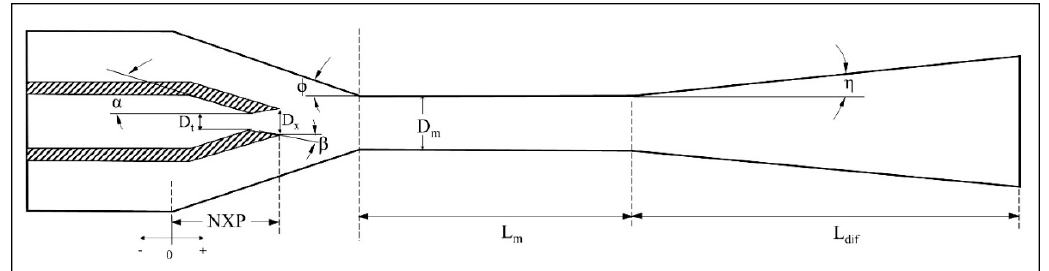
Figure 2. Typical ejector geometry parameters.